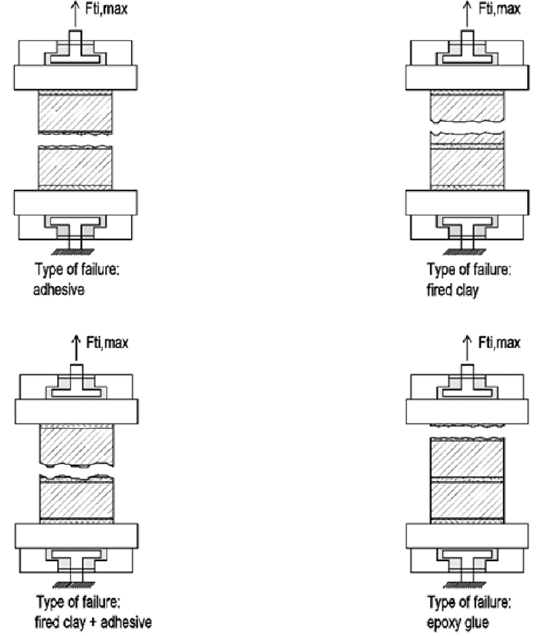
Figure 7. The possible types of failure of the sample in the adhesion